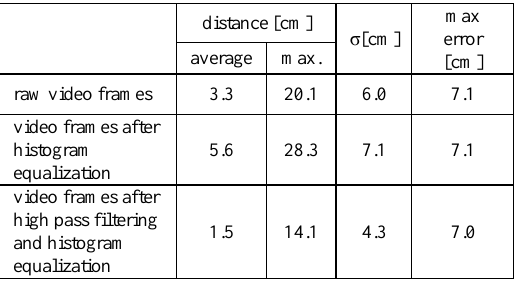
Table 2. Results of the accuracy assessment of point clouds generated from video data which had been processed in three different ways